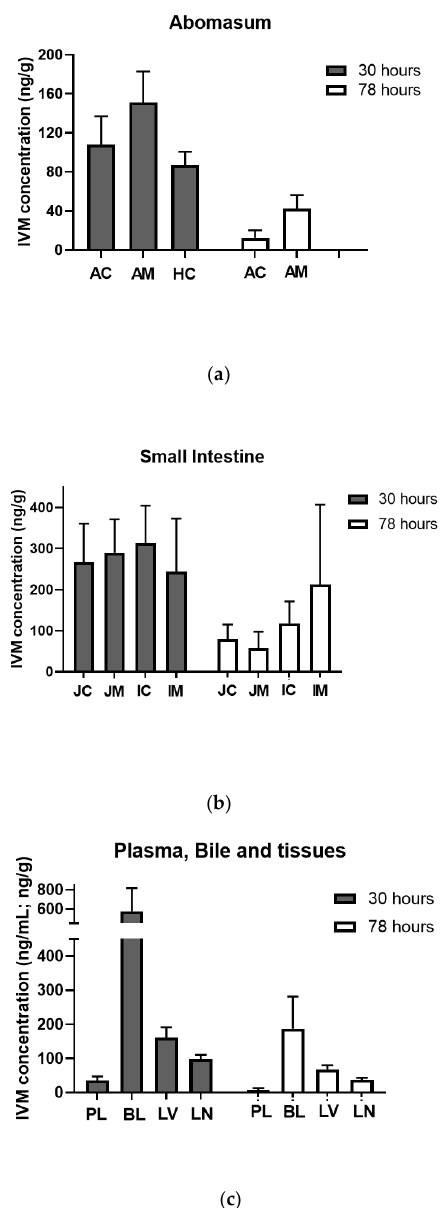
Figure 4. Mean (±SD) ivermectin (IVM) concentrations obtained in plasma, target tissues, and H. contortus after its oral administration as an emulsion (one dose, 0.2 mg/kg) combined with R-CNE (four doses every 24 h of 100 mg/kg) to lambs ( n = 6) artificially infected with resistant H. contortus . ( a ) AC: abomasum content, AM: abomasum mucosa, HC: H. contortus ; ( b ) JC: jejunum content, JM: jejunum mucosa, IC: ileum content, IM: ileum mucosa; ( c ) PL: plasma, BL: bile, LV: liver, LN: lung. IVM concentrations measured at 30 h were significantly higher compared to those measured at 78 h post treatment for AC, AM, JC, JM, IC, PL, BL, LV, and LN ( p ≤ 0.05). R-CNE was quantified in the plasma, target tissues, and H. contortus . The concentra- tions in tissues were higher at 78 h post treatment (6 h after the fourth dose) compared to 30 h (6 h after the second dose), which may reflect an accumulation process. Concentra- tions measured in plasma were in the range of 0.5–0.88 µg/mL. Mean R-CNE concentra- tions in H. contortus adults at 30 h post treatment were 4.56 µg/g, correlating with the concentrations obtained in the abomasum. The highest concentrations were found in the abomasum and cranial jejunum (between 4 and 12 µg/g) compared to the caudal segments of the intestine (ileum), where concentrations ranged between 0.5 and 4.5 µg/g. While R- CNE concentrations were not detected in the lung tissue, the quantified concentrations were between 0.7 and 2 µg/g or µg/mL in the liver and bile. Figure 5 summarizes the R- CNE concentrations in the different target tissues and in H. contortus . The combined treat- ment of R-CNE + IVM significantly reduced the FEC on days 7 and 14 post treatment. The FECR on different days with the respective confidence intervals is shown in Table 3.